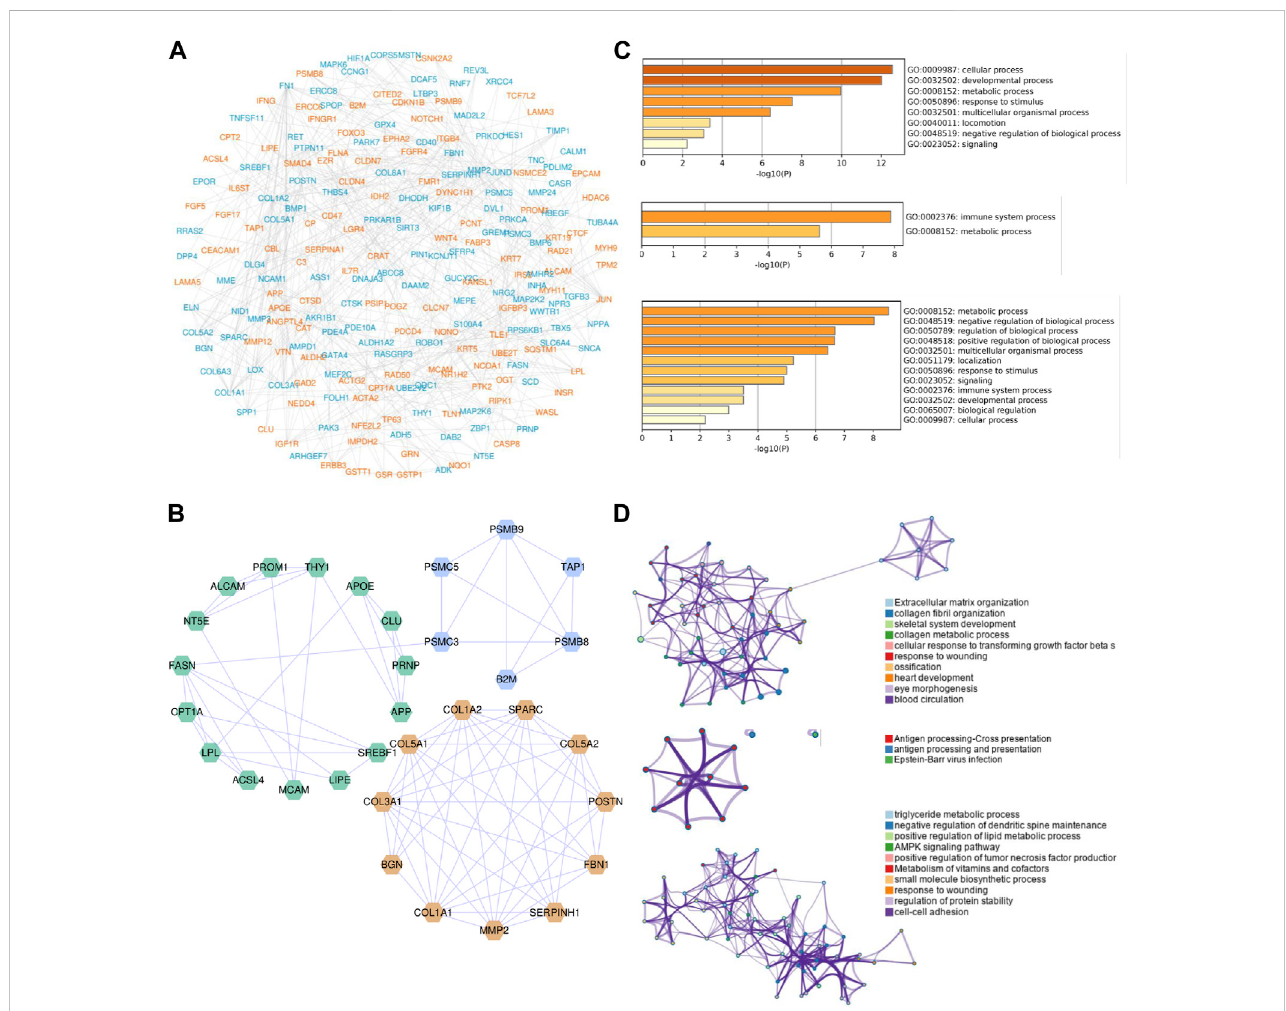
FIGURE 4 PPI network construction and module analysis of signi fi cant CPRGs. (A) PPI network of signi fi cant CPRGs. (B) The top three gene clusters based on module analysis. (C) GO enrichment analysis of the top three gene clusters. (D) Pathway and process enrichment analysis of the top three gene clusters. For (A) , yellow labels represent upregulated CPRGs and blue labels for downregulated CPRGs. For (B) , yellow, blue, and green labels represent gene model 1, 2, and 3, respectively. For (D) , each node represents an enriched term and is colored by cluster ID. PPI = protein-protein interaction. CP = chronic prostatitis; CPPS, chronic pelvic pain syndrome; CPRGs, CP/CPPS-related genes; GO, Gene